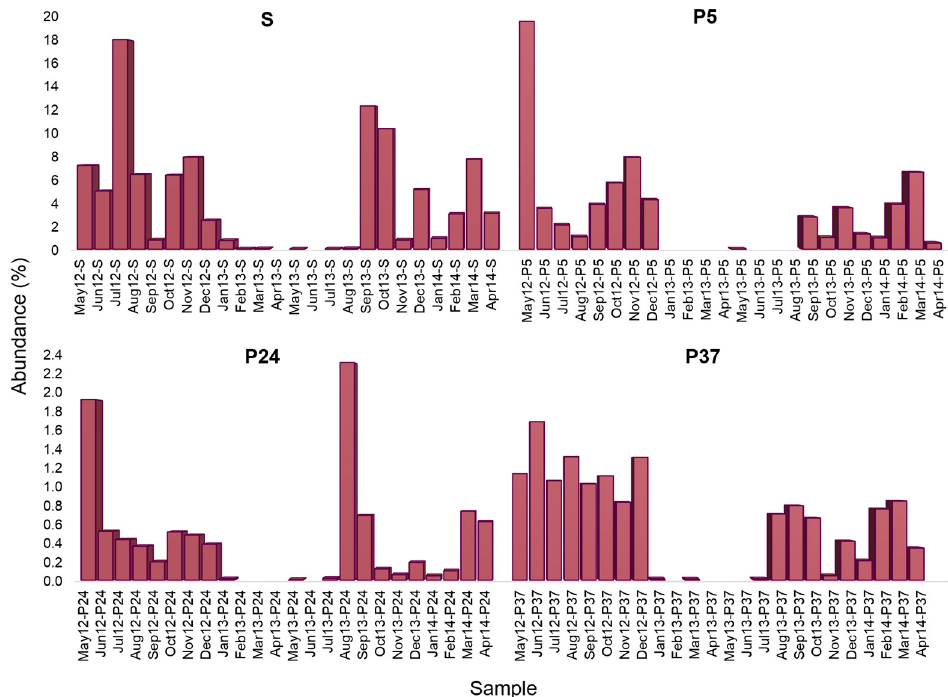
Figure 2. Occurrence of Enterobacteriaceae among the ST sampling sites during the two-year period, May 2012–April